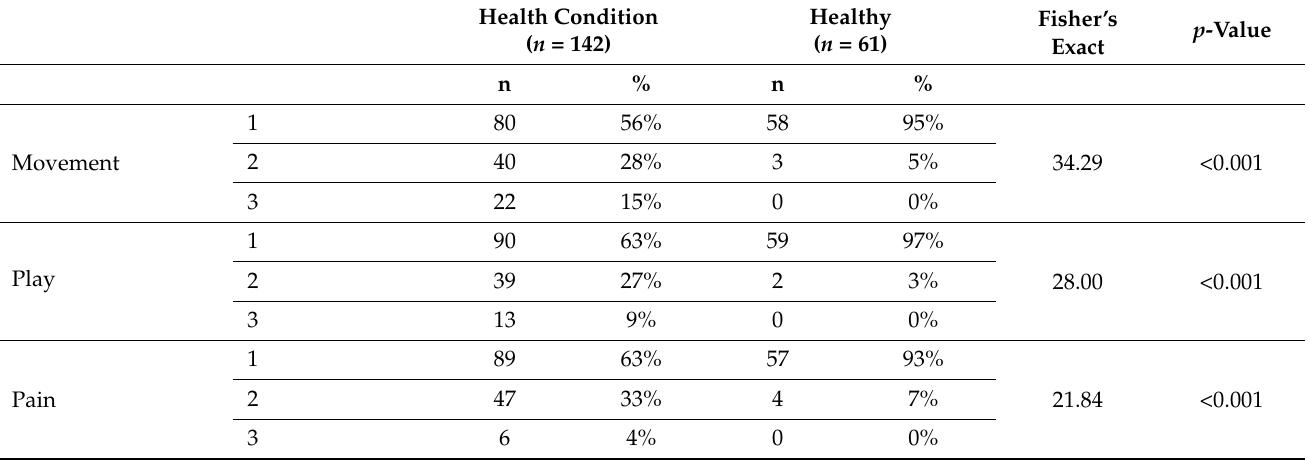
Table 2. TANDI dimension responses for children with a health condition and a healthy sample. (Total Sample N = 203). Health Condition